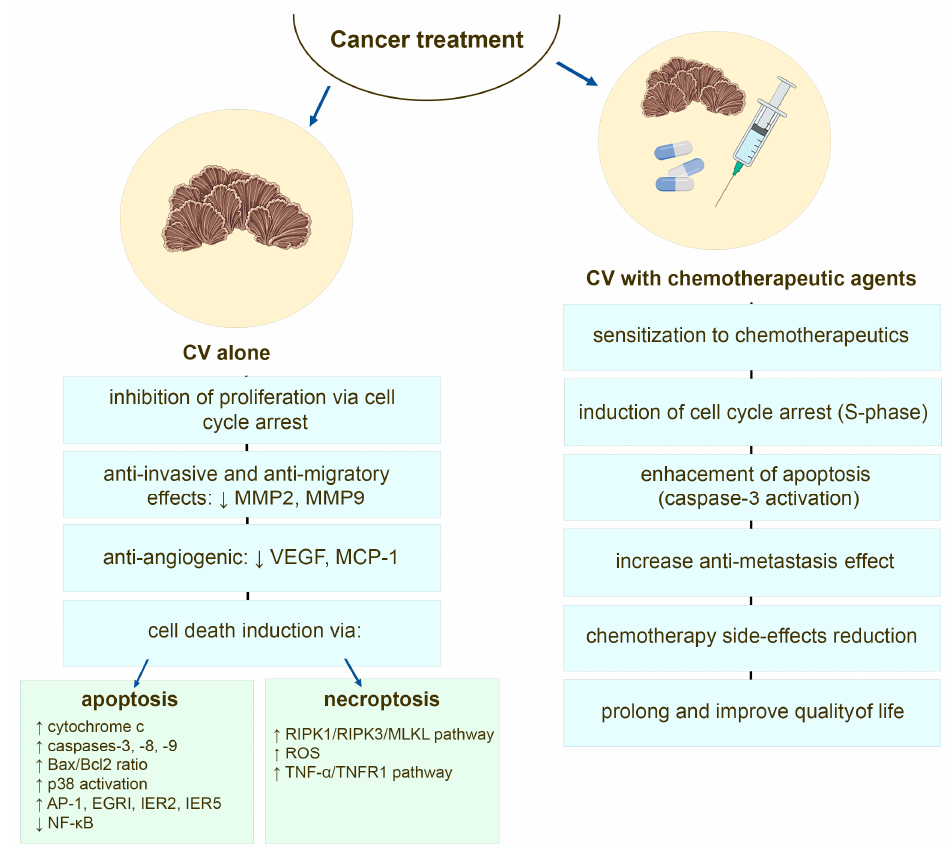
Figure 3. The potential anti-cancer mechanisms of the compounds derived from Coriolus versicolor mushroom.